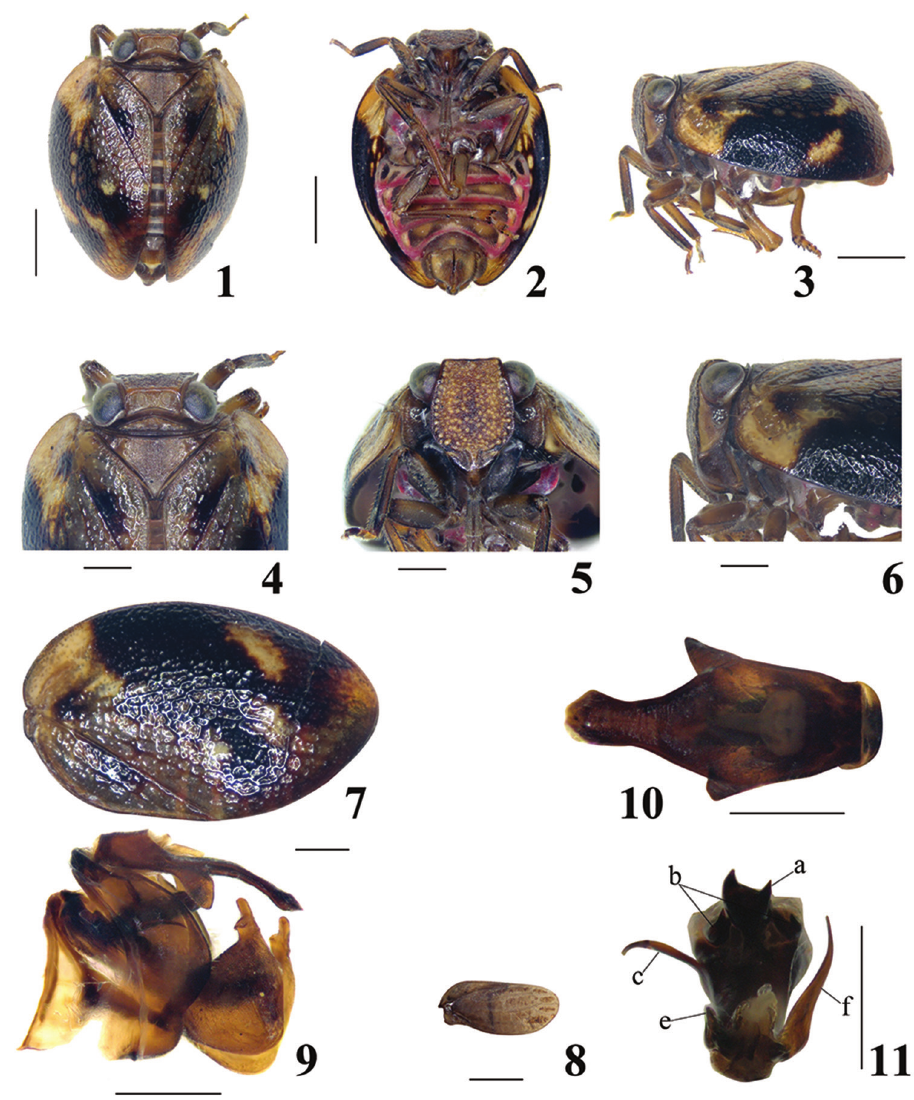
Figures 1–11. E. guangxiensis sp. n. 1 Adult (male), dorsal view 2 Adult (male), in ventral view 3 Adult (male), in lateral view 4 Head and thorax (male), in dorsal view 5 Face (male), in frontal view 6 Head (male), in lateral view 7 Fore wing (male) 8 Hind wing (male) 9 Male genitalia, in lateral view 10 Anal tube, in dorsal view 11 Penis, in dorsal view from caudad; Scale bars: 1.0 mm ( 1–3 ), 0.5 mm ( 4–11 ). with wide median carina. Pronotum (Figure 4) short, with keel-shaped margins. Para- discal fields very narrow behind the eyes. Mesonotum (Figure 4) 3.3 times longer than pronotum in midline, with lateral carinae. Fore wings (Figure 7) oval, with smoothed, poorly recognizable reticulate venation; CuP distinct. Hind wings (Figure 8)